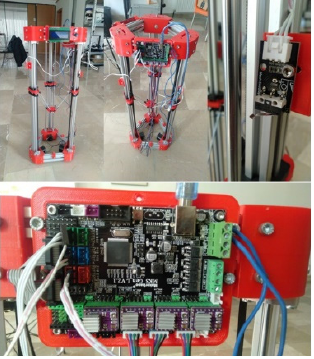
Figure 1. Three-dimensional printer designed for this study.